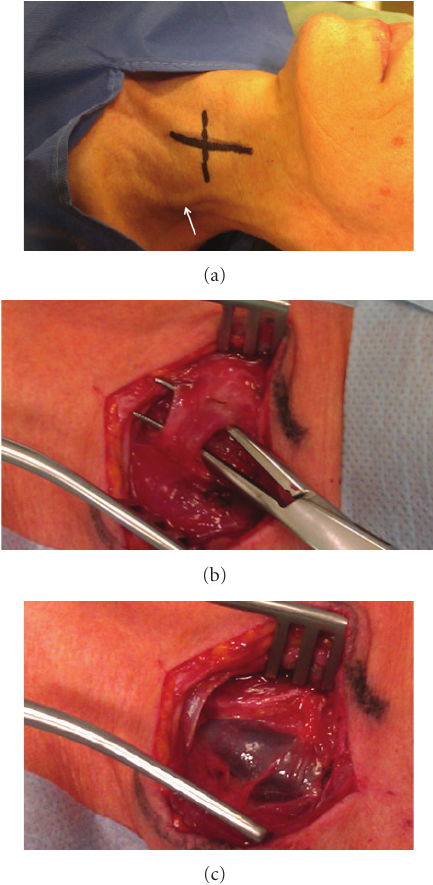
Figure 4: Surgical procedure. (a) Patient prepared for surgical decompression of the internal jugular vein; course of the vein and omohyoid muscle are marked in black, please note the widened external jugular vein (white arrow), (b) atypical omohyoid muscle compressing the internal jugular vein: (c) fully widened internal jugular vein after surgical transection of the muscle.